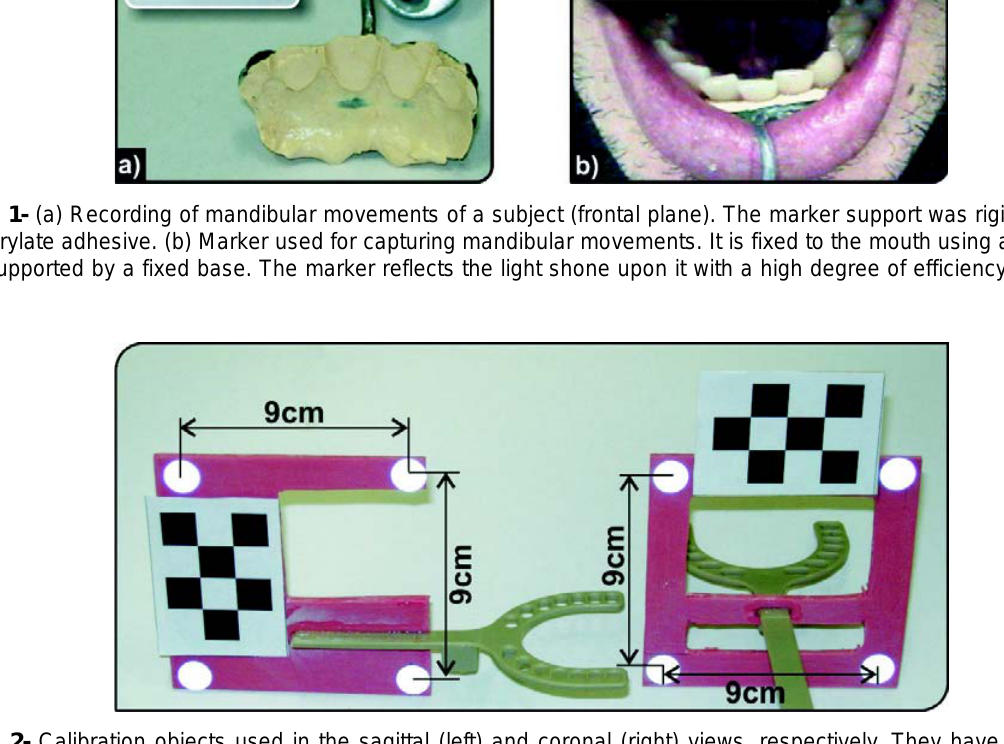
FIGURE 2- Calibration objects used in the sagittal (left) and coronal (right) views, respectively. They have a base that is placed between the teeth of the subject